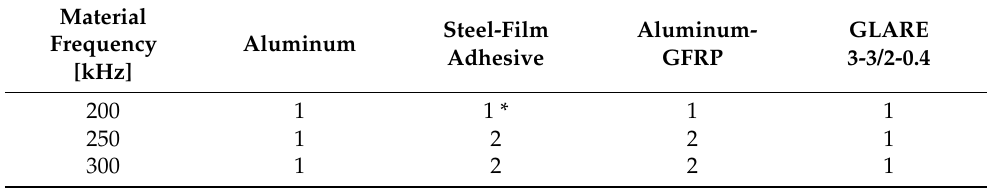
Table 4. Overview of the time signal assignment in signal group 1 and signal group 2.